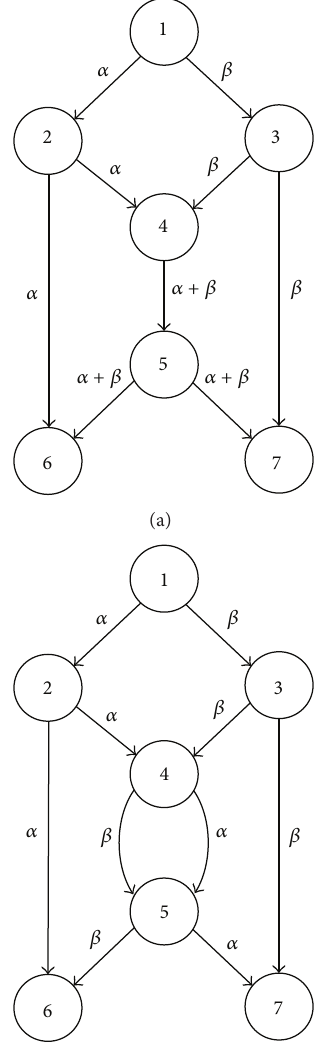
Figure 1: Basic idea of network